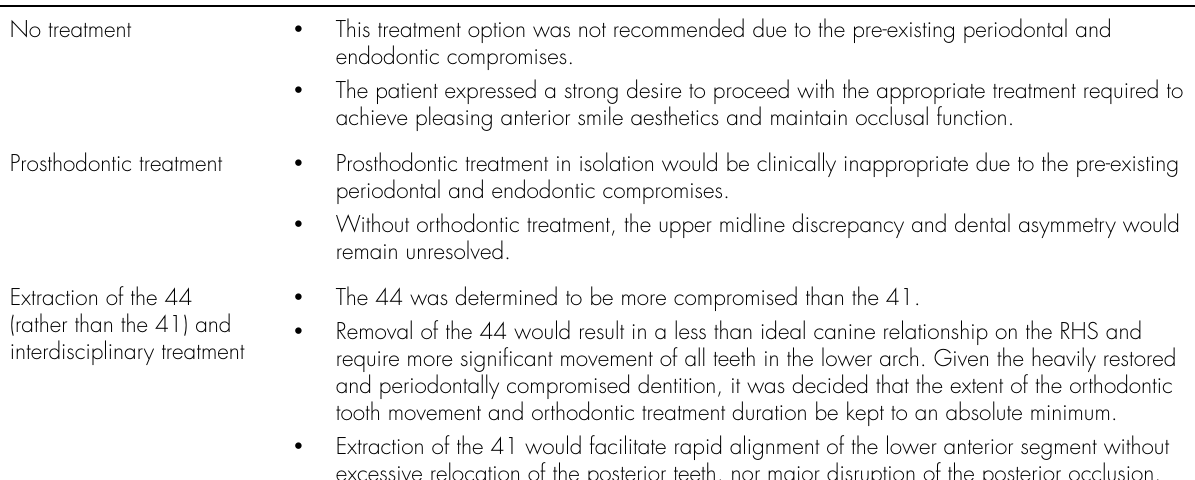
Table IV. Alternative treatment